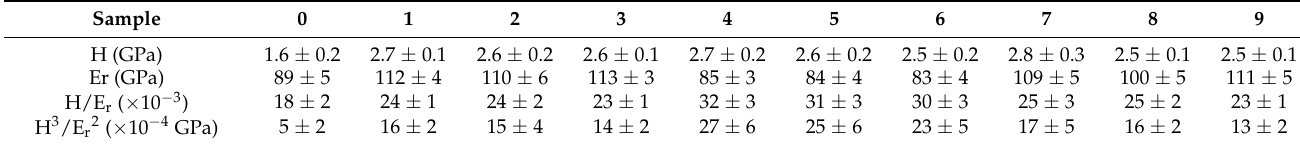
Figure 6. Mechanical properties of coatings. The error bar belongs in ( a ) to the standard deviation and in ( b ) to propagation of errors. Table 2. H, Er, H/E r and H 3 /E r2 values of the coatings.